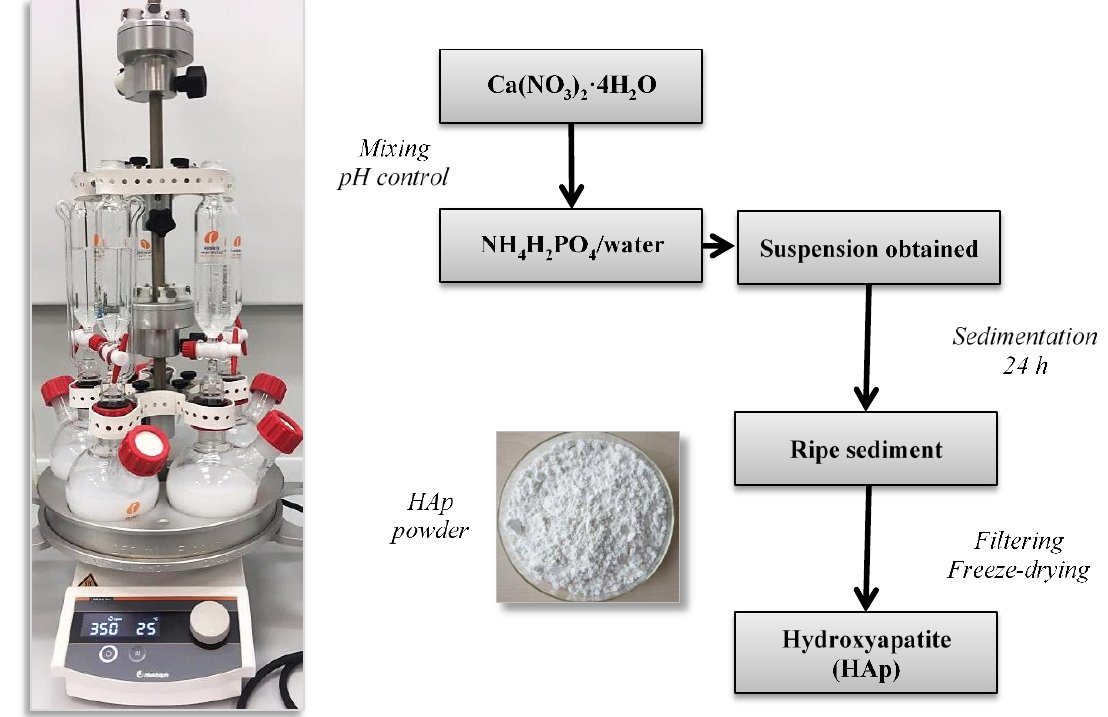
Figure 10. The equipment used (left) and the scheme (right) of the preparation of hydroxyapatite.